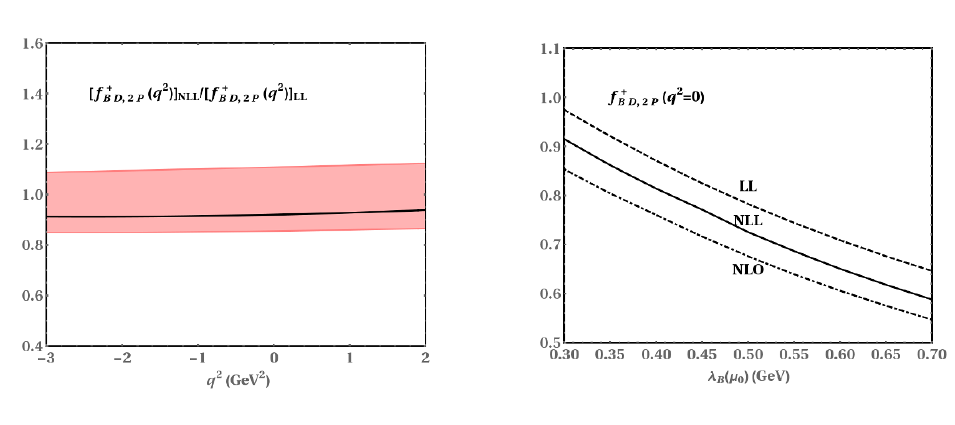
Figure 6 . Left: the q 2 dependence of the ratio [ f + ( q 2 )] NLL = [ f + ( q 2 )] LL with uncertainties BD; 2 P BD; 2 P from the variations of both the hard and hard-collinear scales. Right: dependence of the two-particle contributions to f + ( q 2 = 0), at LL, NLO and (partial) NLL accuracy, on the inverse moment of BD the leading twist B -meson DA (cid:21) B ( (cid:22) 0